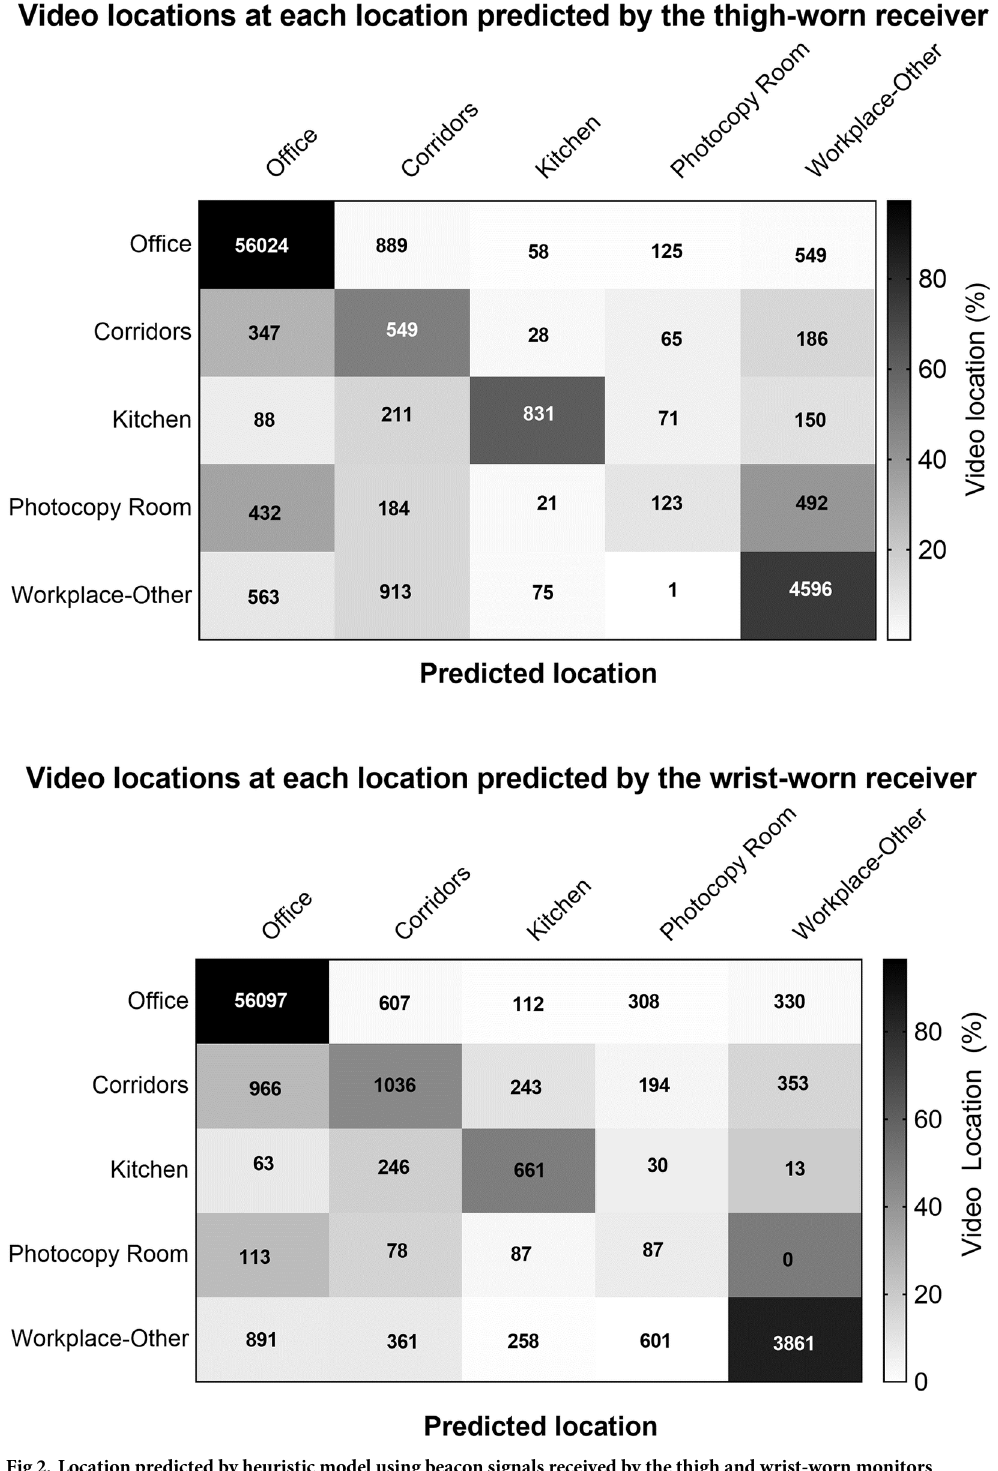
Fig 2. Location predicted by heuristic model using beacon signals received by the thigh and wrist-worn monitors compared with actual location determined by video camera recordings.